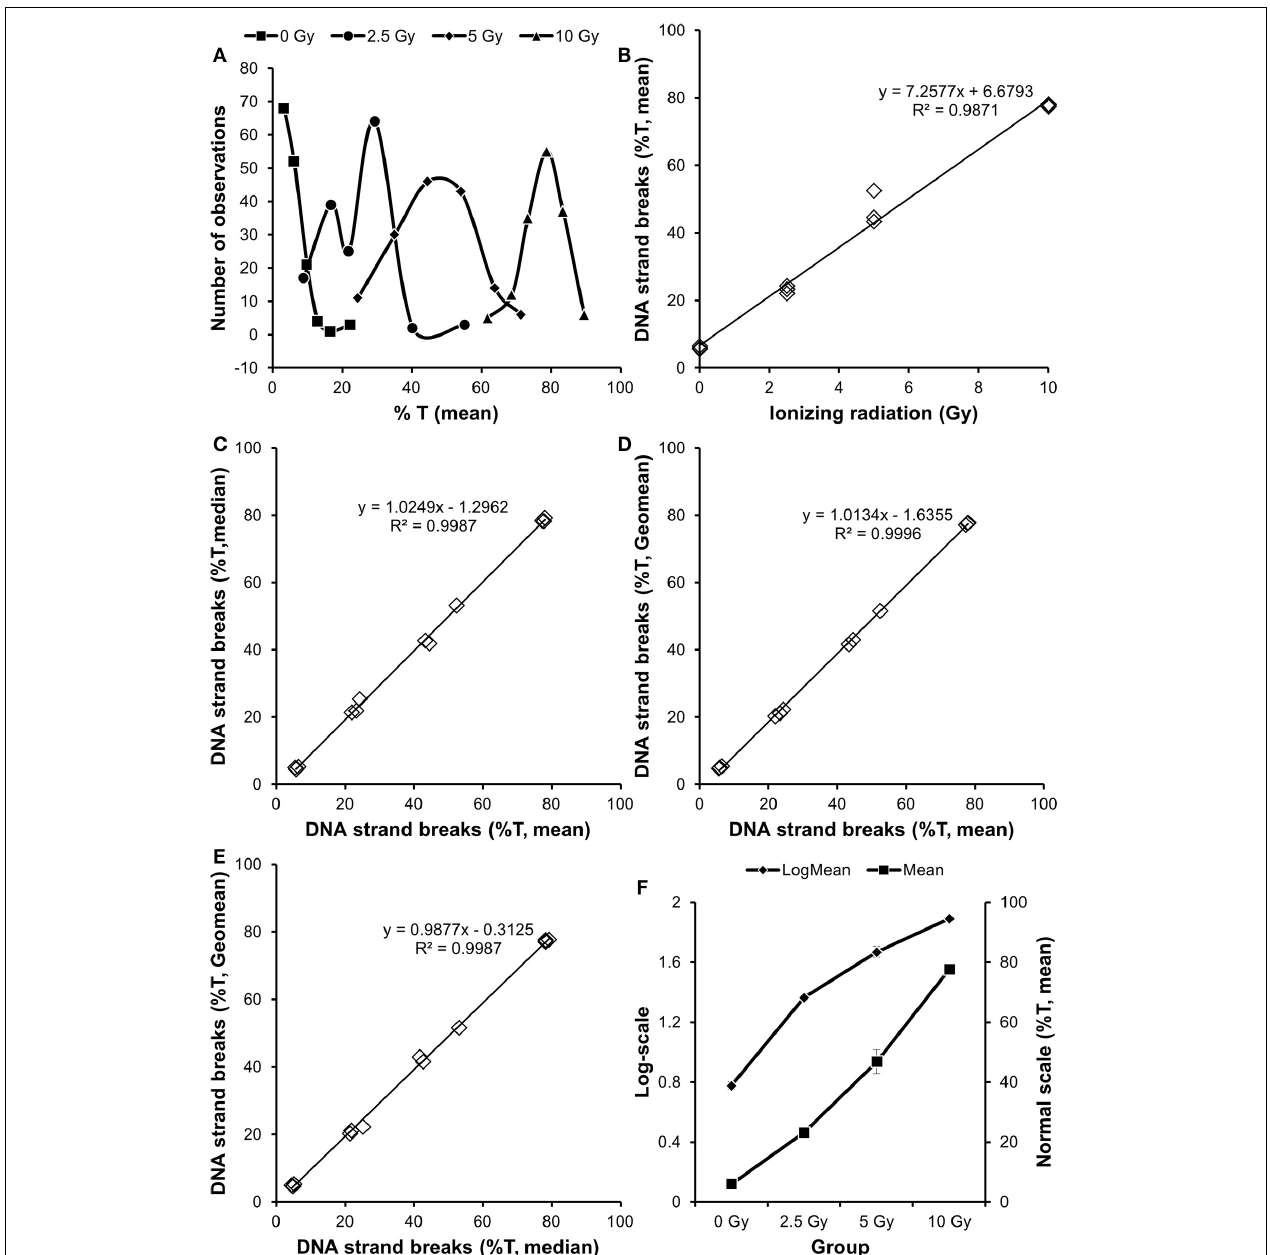
FIGURE 1 | Analysisofassociationbetweenexposuretoionizingradiation andlevelofDNAdamage. Themeanvaluesfromindividual Comets displayed variation that tended to shift dose-dependently from non-normal distribution to normal distribution (A) . The dataset consisted of 3 independent Samples per